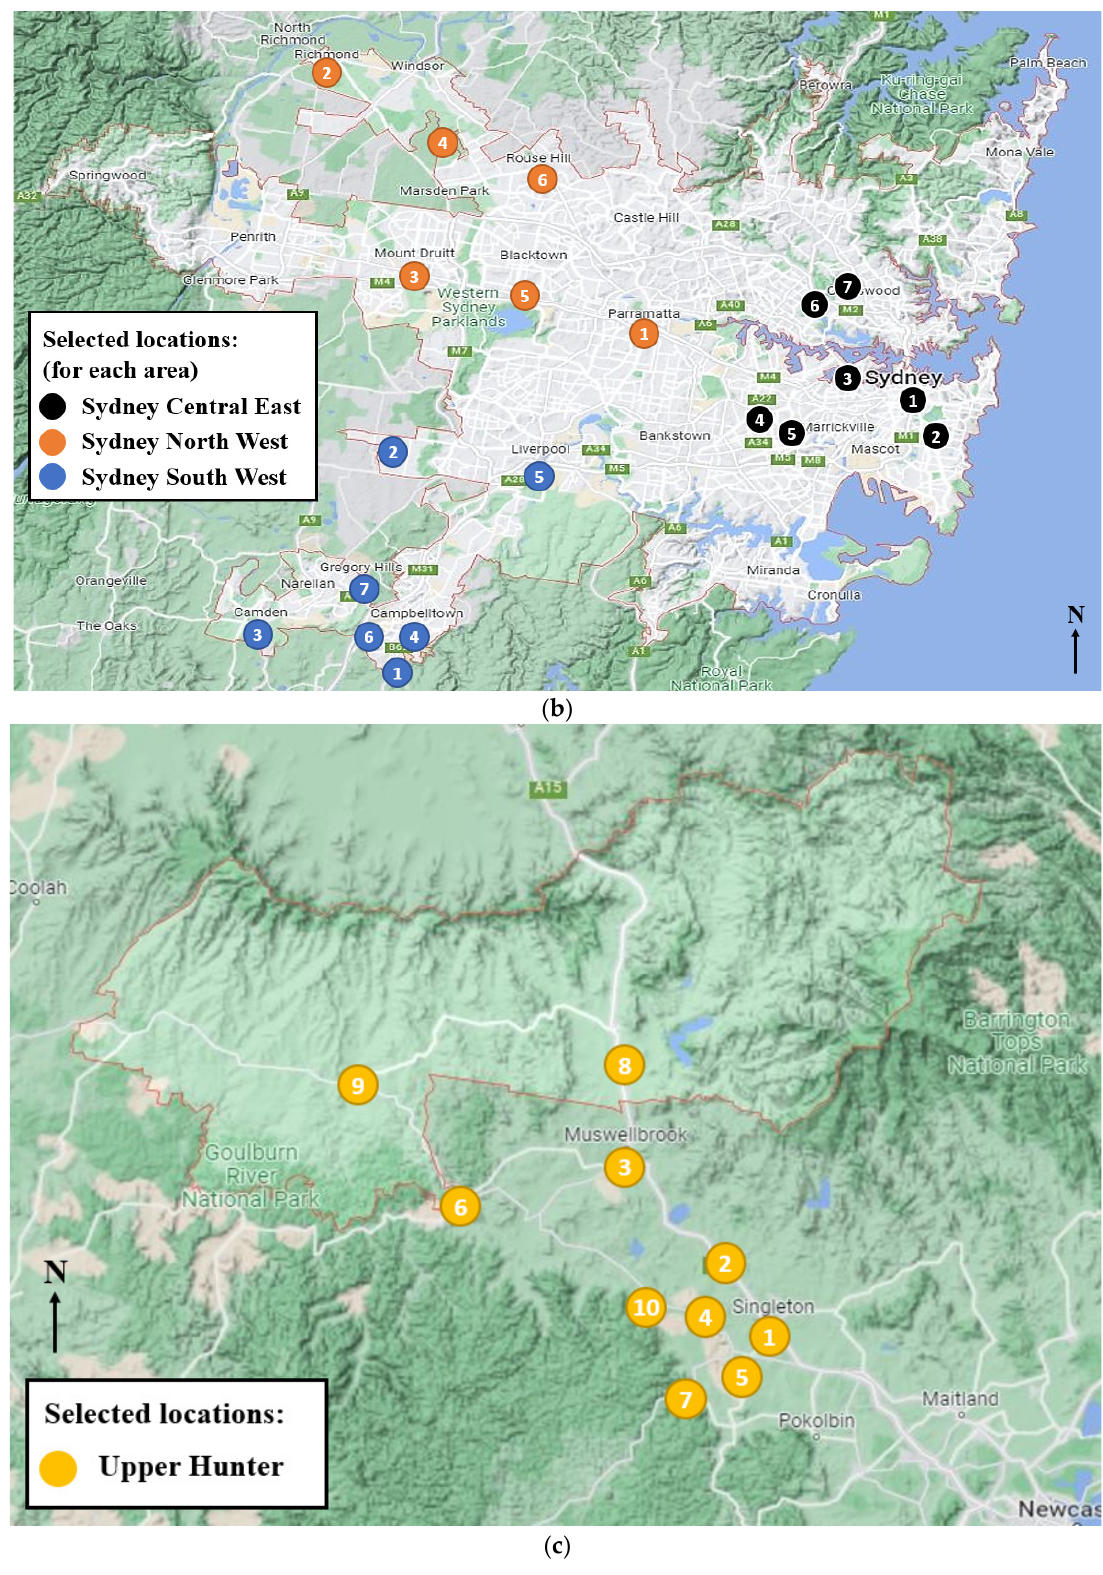
Figure 1. The location map of the sight of the air-quality analysis. ( a ) selected areas including Upper Hunter and Sydney, ( b ) selected sight of air-quality analysis in Sydney, and ( c ) selected sight of air-quality analysis in Upper Hunter. (All numbers are referred to the selected locations which can be seen in Table 1).